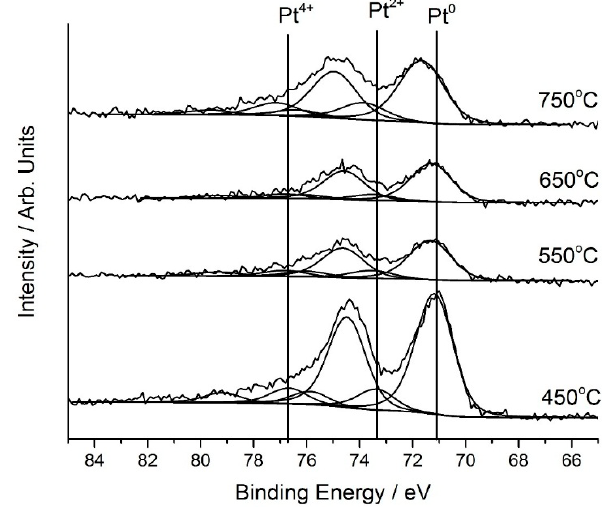
Figure 3. Pt(4f) core-level spectra for a 2.5 wt.% Pt/SiO 2 catalyst showing the effect of increasing calcination